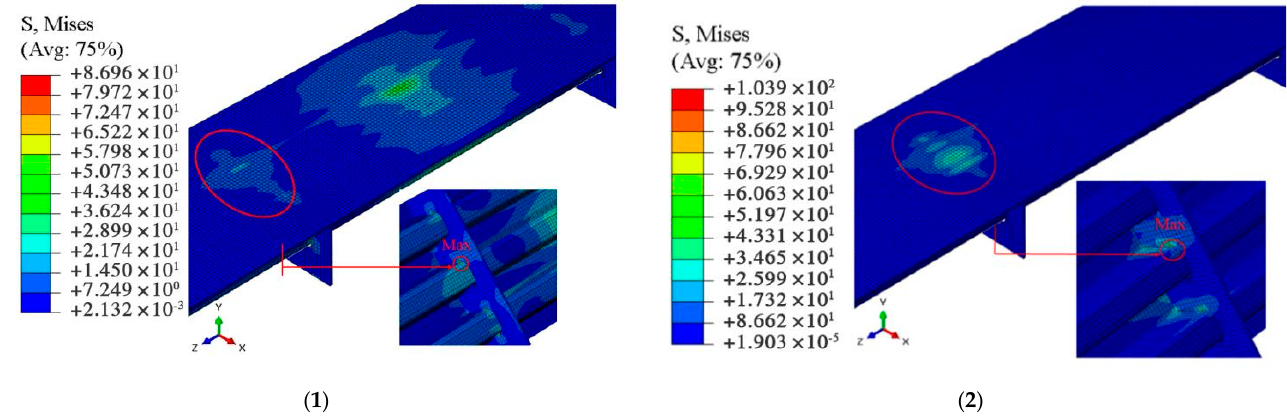
Figure 5. Stress state of the bridge deck (unit: MPa). ( 1 ) Mid-span loading; ( 2 ) diaphragm loading. The stress state results of FE model are listed in Table 3. Table 3. Stress results of FE model.